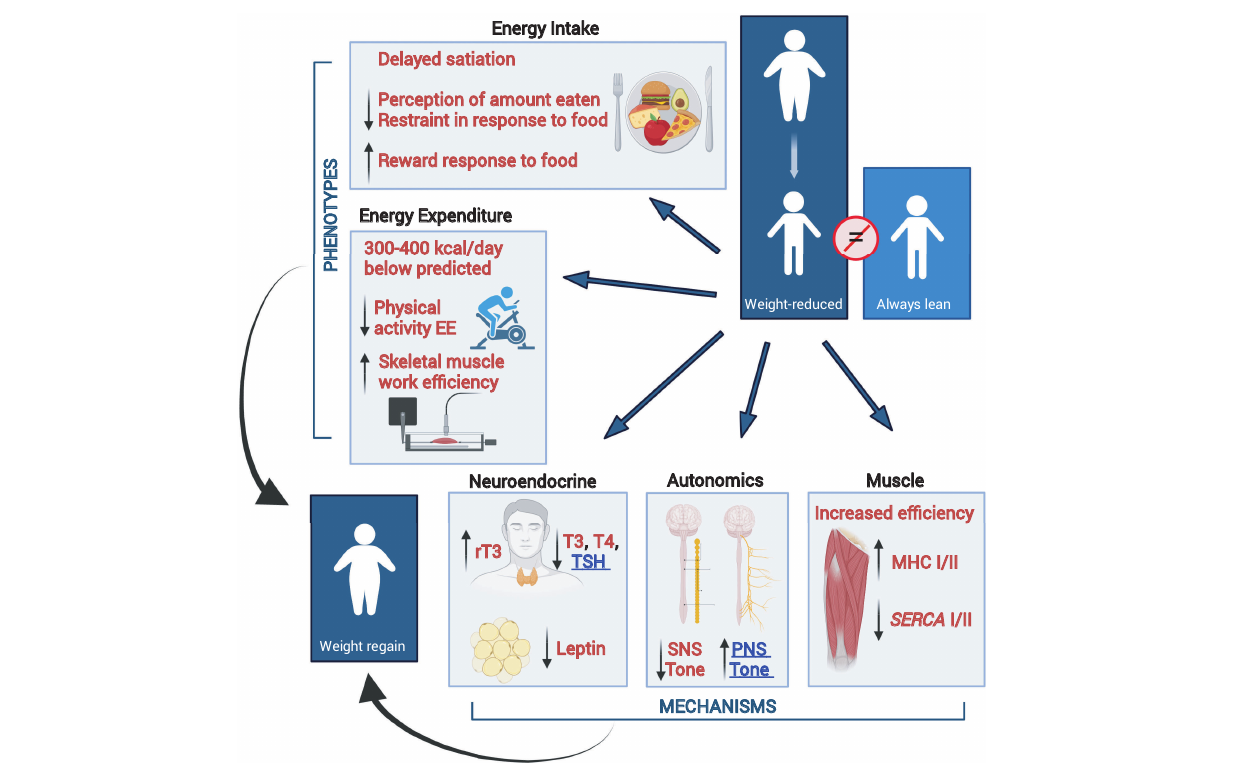
FIGURE 2 | Changes from baseline in energy balance and homeostatic systems during maintenance of a 10% or greater reduced body weight and their responsiveness to exogenous leptin in individuals who initially had obesity or never had obesity (Rosenbaum and Leibel, 2014). Energy expenditure due to physical activity is calculated as the difference between direct measurement of 24-h energy expenditure and measurement of resting energy expenditure plus diet-induced thermogenesis. Eating behavior, including energy intake, is examined by visual analog scales during a fixed liquid formula meal, kcal of the liquid formula consumed to reach satiation, and by fMRI studies of brain responses to food. Assessments of autonomic nervous system activity were made by analyses of heart rate variability during sequential blockade of the parasympathetic and sympathetic nervous systems with atropine and esmolol, respectively, and by 24-h urine